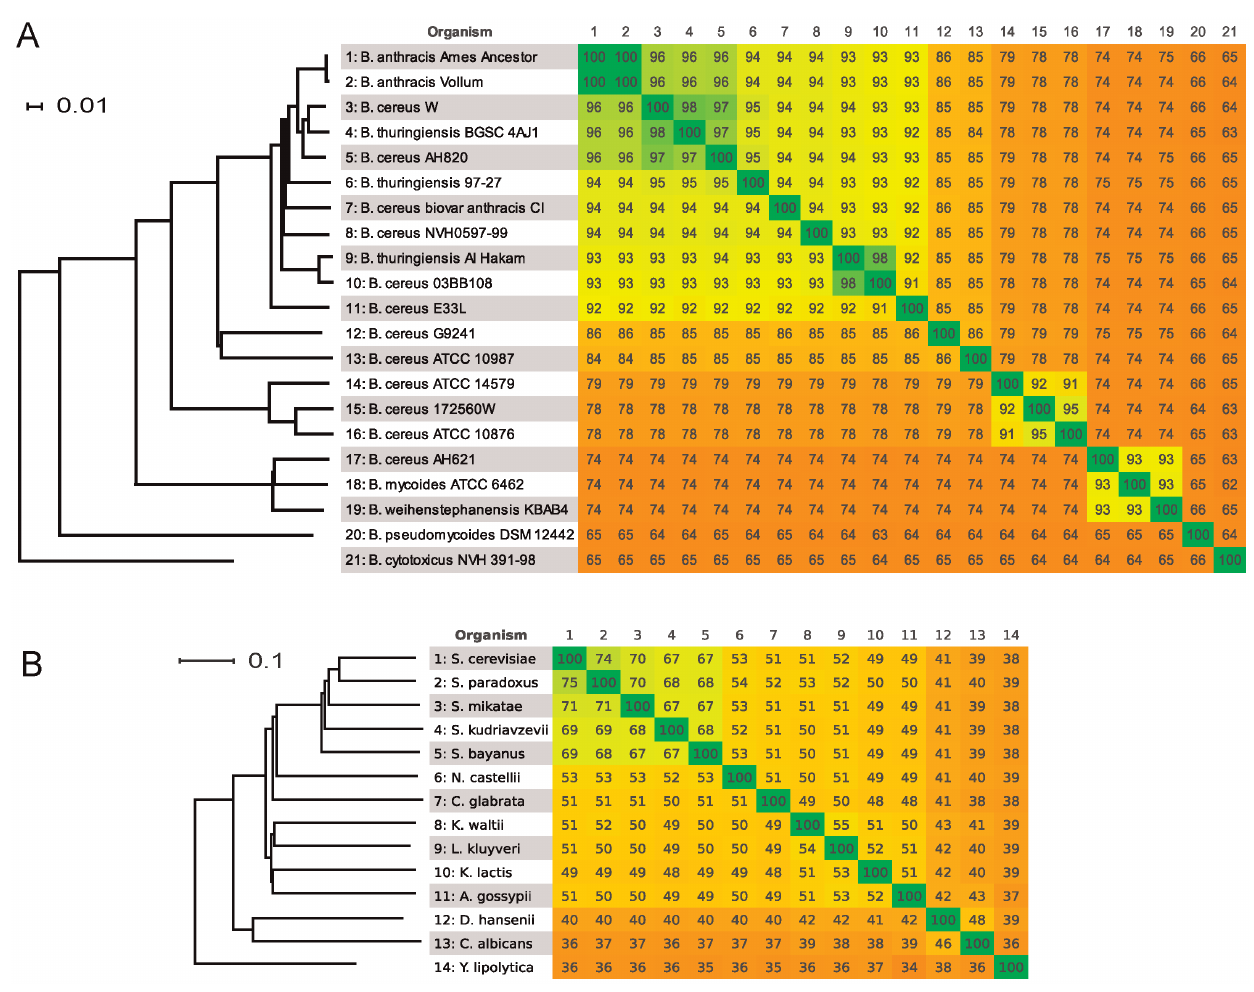
Figure 3. Phylogenomic overview in Gegenees. Both heat-plots of the similarity matrices and trees created from the same data are shown. A . A Gegenees heat-plot over a set of Bacillus strains that had previously been analyzed by MLST [17]. The heat-plot is based on a fragmented alignment using BLASTN made with settings 200/100. The cutoff threshold for non-conserved material was 30%. A dendrogram was produced in SplitsTree 4 (using neighbor joining method) made from a Nexus file exported from Gegenees. B. cytotoxicus was set as outgroup. The clustering is very similar to previously published trees. The scale bar represents a 1% difference in average BLASTN score similarity. B . A Gegenees heat-plot over a set of yeast genomes that has been analyzed before with different phylogenomic methods. These genomes are more distant from each other and a BLASTN comparison does not resolve them well (data not shown). A fragmented alignment in TBLASTX mode was performed with settings 200/200. The cutoff threshold for non-conserved material was 20%. A dendrogram was produced in SplitsTree 4 (using neighbor joining method) made from a distance matrix Nexus file exported from Gegenees. Y. lipolytica was set as outgroup. The clustering here is also very similar to the previously published trees [2]. The scale bar represents a 10% difference in average TBLASTX score